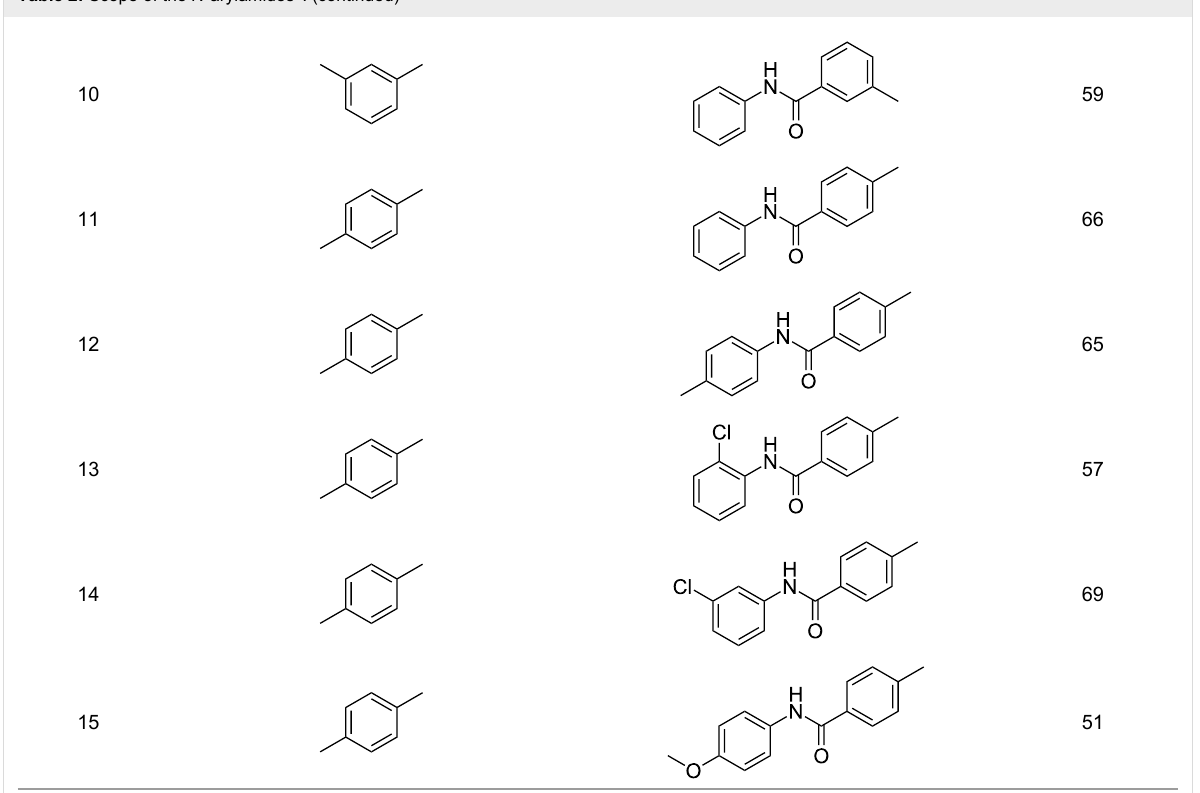
Table 2: Scope of the N -arylamides a .